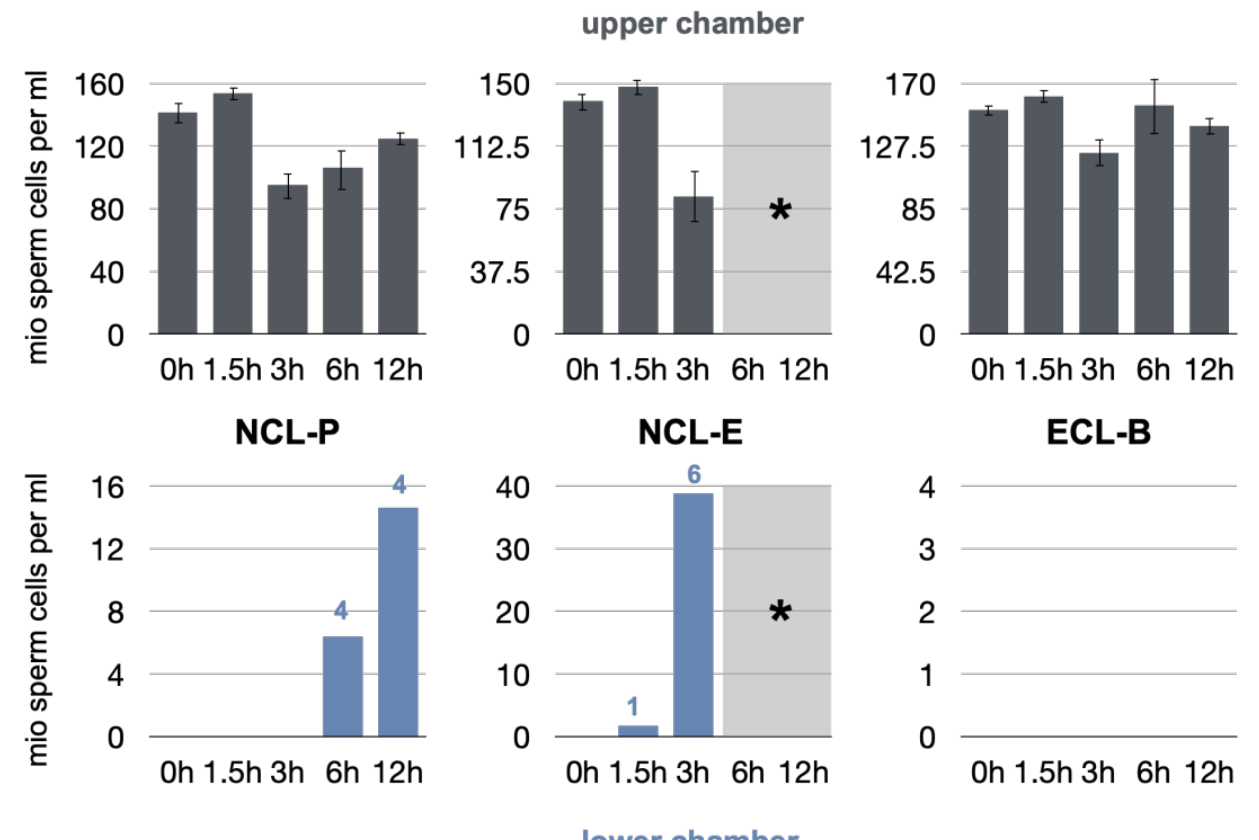
Figure 4. Results of the sperm cell counting (millions per milliliter) after different degradation times (bar charts with S.E. in the upper chamber). Results of the triplicate measurements after 10 and 30 min are given for the upper and lower chambers separately. The numbers given in the lower chamber indicate the actual number of leaking specimens (* Note: No measurements could be performed for NCL-E after 6 h, as the membrane had completely disintegrated and was not usable).